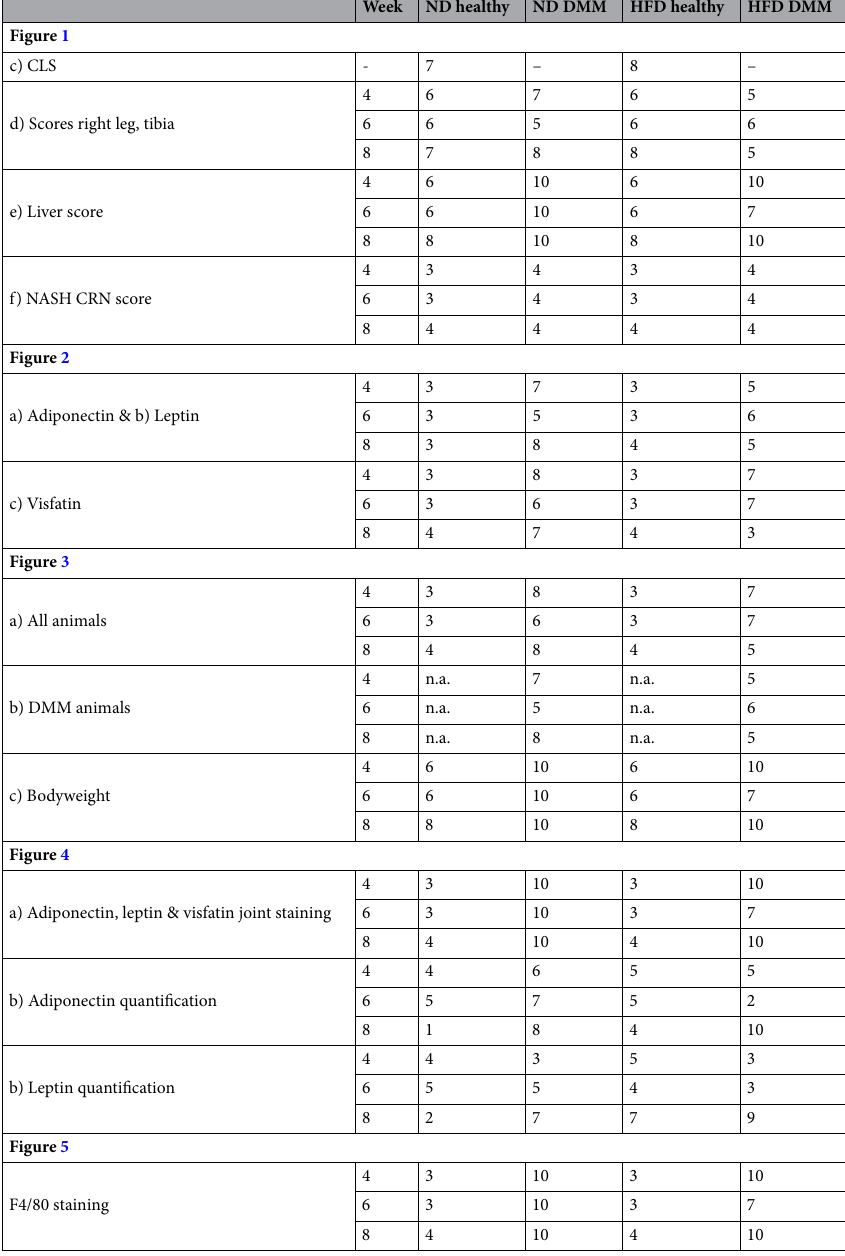
Table 2. Number of animals involved in each experiment for all groups: Mean values of experimental replicates were calculated and statistics performed using mean values of each biological replicate (animal). N.a. = not